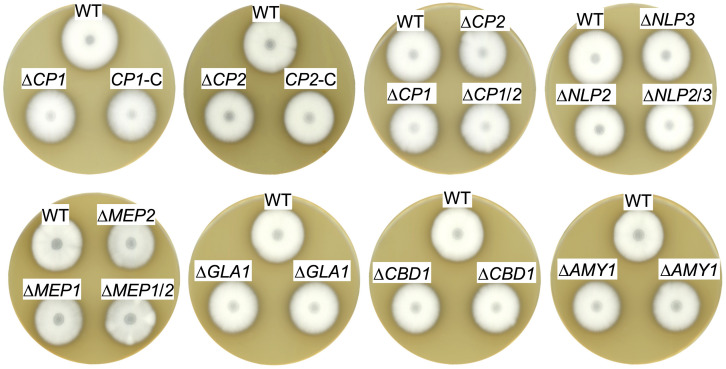
Exoproteins specifically secreted in xylem sap are dispensable for V. dahliae ex planta phenotype. The same number of spores of V. dahliae JR2 wildtype (WT) and indicated deletion mutant (ΔCP1, ΔCP2, ΔCP1/2, ΔNLP2, ΔNLP3, ΔNLP2/3, ΔMEP1, ΔMEP2, ΔMEP1/2, ΔGLA1, ΔCBD1, and ΔAMY1) and complementation (CP1-C, CP2-C) strains were point inoculated on simulated xylem medium (SXM) plates and incubated at 25°C for 10 days. For ΔAMY1, ΔGLA1, and ΔCBD1 mutants two transformants were spotted. Top-view scans of the colonies show a similar phenotype of all strains.